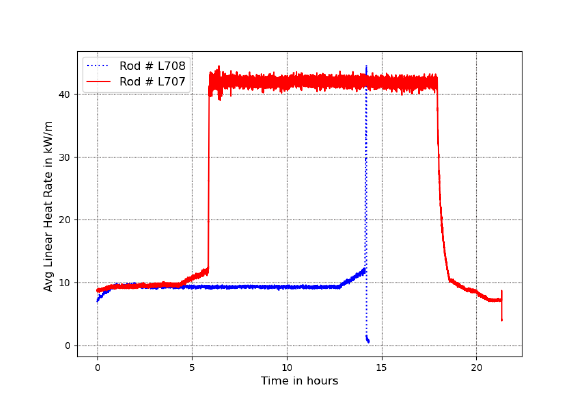
Figure 4. SCIP II ramp